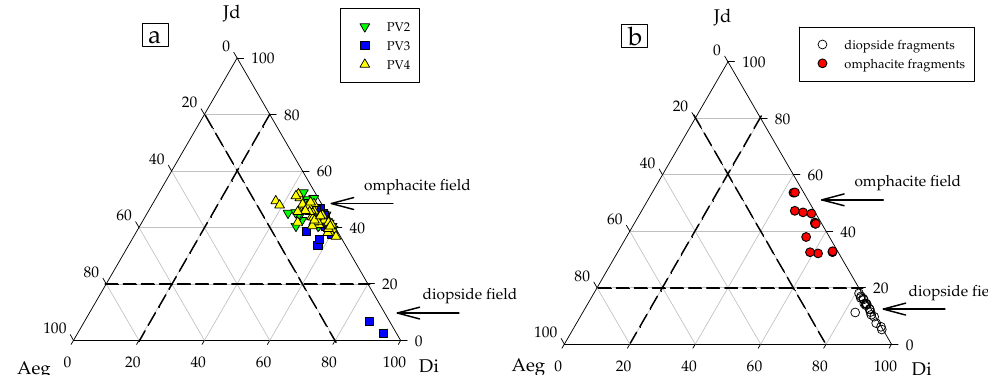
Figure 4. Di-Jd-Aeg diagram of the individual data points of samples PV2, 3, 4 ( a ) and of diopside and omphacite fragments ( b ).